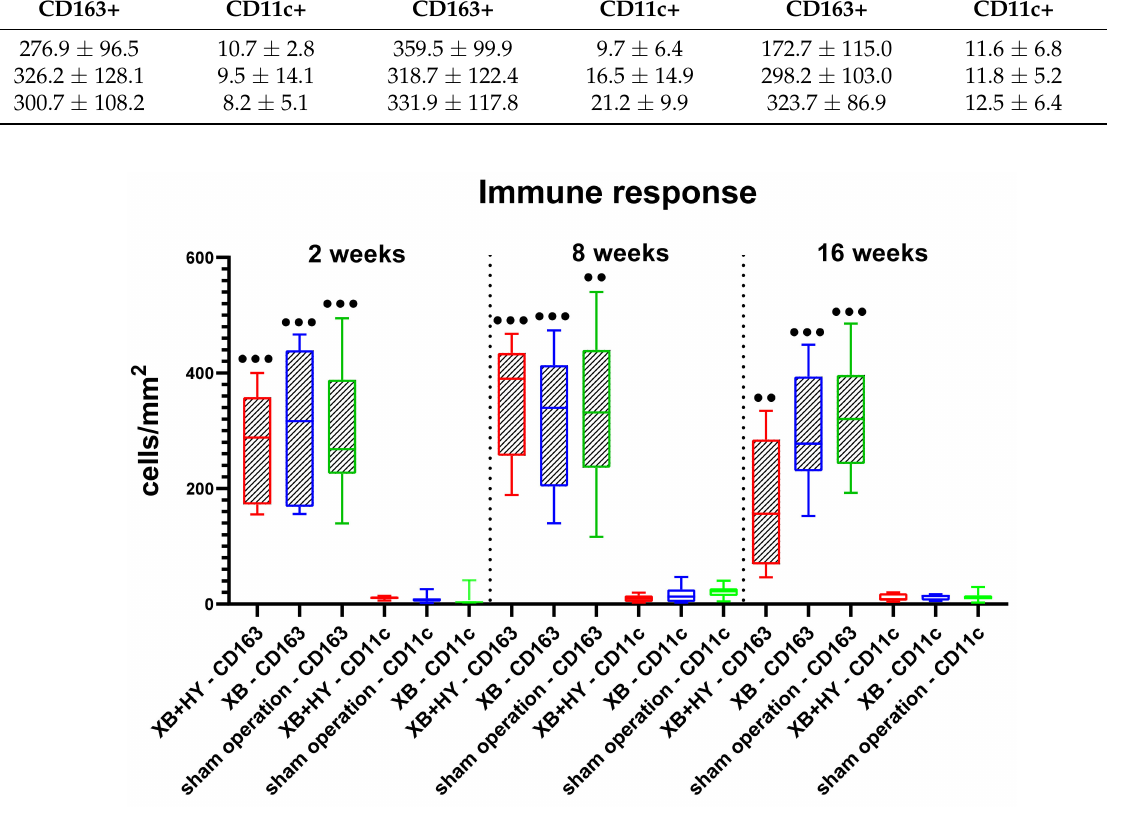
Figure 7. Results of the histomorphometrical analysis of the immune response represented by the numbers of CD163-positive anti- and CD11c-proinflammatory macrophages within the